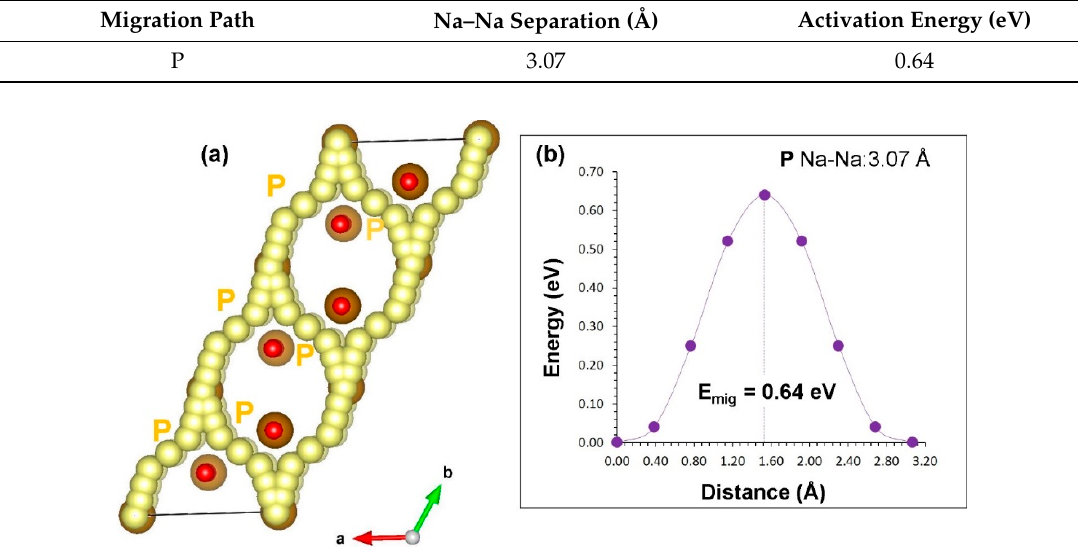
Figure 3. Na ion migration in α -NaFeO 2 : ( a ) long migration paths and ( b ) energy profile of Na vacancy hopping between two adjacent Na sites.